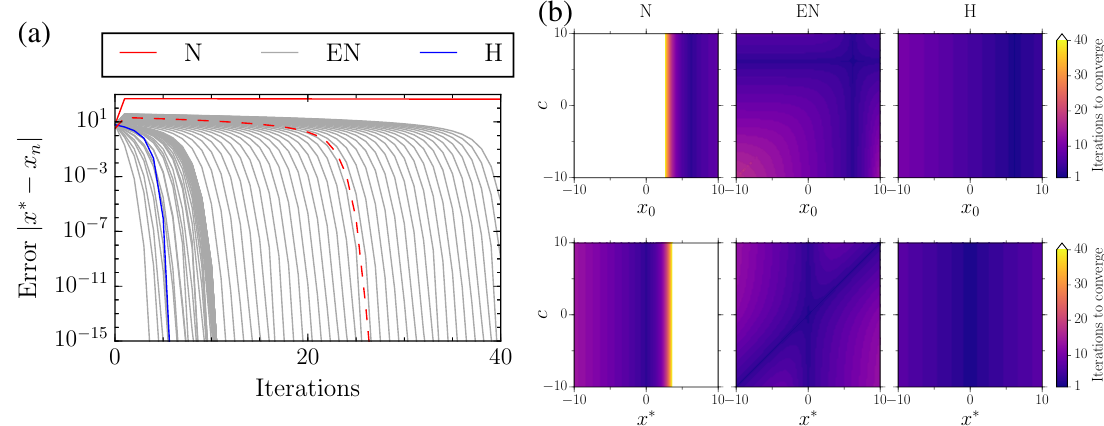
Figure 1. ( a ) Convergence of the standard Newton’s method (red lines), the Extended Newton method with c ∈ ( − 50,50 ) (gray lines), and the Halley’s method (blue line) for solving e x − 500 = 0 (solid curves with initial guess x 0 = 0 and dashed curve with initial guess x 0 = 3). ( b ) (From left) Iterations taken to converge for the standard Newton’s method, the Extended Newton method, and the Halley’s method for solving r ( x ) = e x − H = 0: with H = 500 and varying initial guess x 0 (top), and with x 0 = 0 and varying H = e x ∗